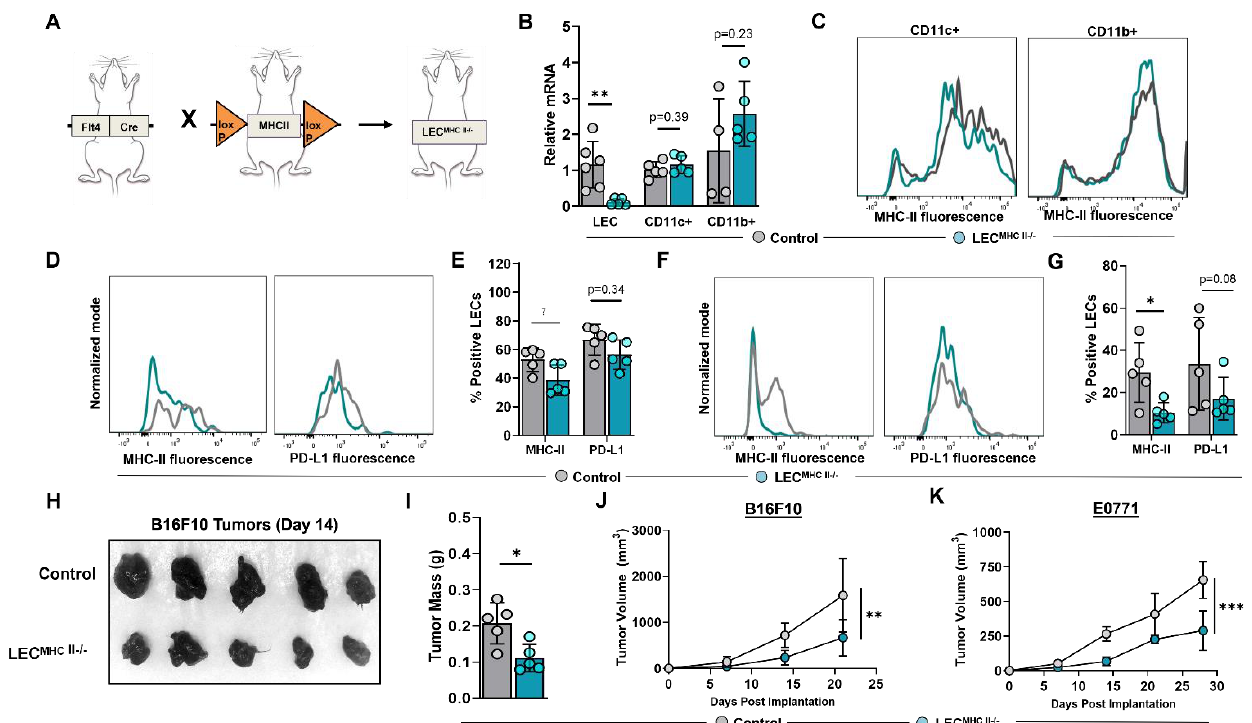
Figure 4. Conditional knock-out of LEC-specific MHC-II expression attenuates growth of heterotopically implanted B16F10 and E0771 tumors. ( A ) Schematic representation of mice genotype bred to generate LEC MHC II − / − mice. ( B ) Relative mRNA expression of MHC-II in FACS-sorted lymph node LECs (CD45-podoplanin+CD31+) and FACS-sorted lymph node CD11c+ and CD11b+ immune cells from WT and LEC MHC-II − / − mice. ( C ) Representative FACS histogram plots of MHC-II MFI in sorted CD11c+ and CD11b+ immune cells from WT and LEC MHC-II − / − mice. ( D ) Representative FACS histogram plots and ( E ) quantification of MHC-II and PD-L1 positive lymph node LECs in WT and LEC MHC-II − / − mice. ( F ) Representative FACS histogram plots and ( G ) quantification of MHC-II and PD-L1 positive peritumoral LECs in WT and LEC MHC-II − / − mice bearing B16F10 at 2 weeks post tumor inoculation. ( H ) Gross images of resected B16F10 tumors and their respective ( I ) mass in grams in WT and LEC MHC-II − / − mice at 2 weeks post tumor inoculation. Statistical significance assessed using unpaired student’s t test on data from at least 4 biological replicates; error represented as SD. *, p < 0.05; **, p < 0.01. ( J , K ) Growth curves of B16F10 ( G ) and E0771 ( H ) in WT and LEC MHC-II − / − mice at various time points (in weeks). Statistical significance assessed using two-way ANOVA, error represented as SD.; **, p < 0.01; ***, p < 0.001.